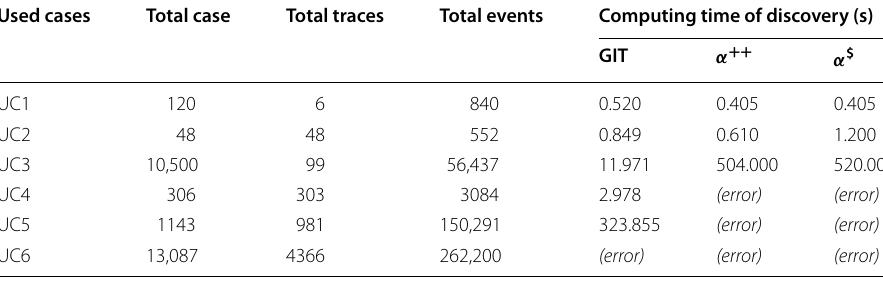
Table 11 Result of discovering computing time Used